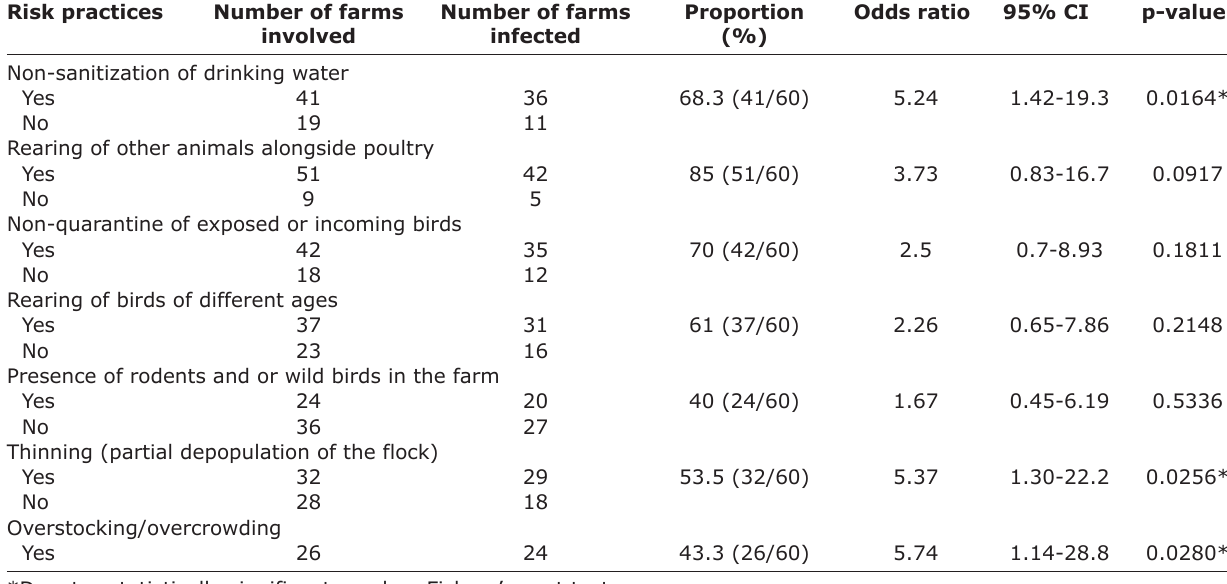
Table-3: Risk factors for thermophilic Campylobacter infection in poultry farms (n=60) survey in Nsukka agricultural zone, Nigeria. Risk